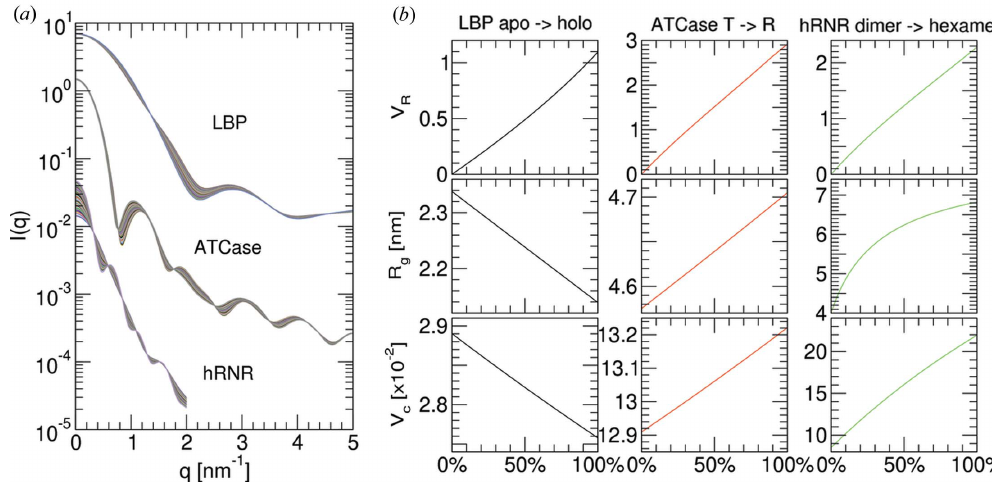
Figure 2 Theoretical modelling of the changes in structural parameters as a function of the mixtures of two conformers. ( a ) Theoretical SAXS profiles of three ligand-triggered population transitions, following open versus closed leucine-binding protein (LBP), T versus R states of aspartate carbamoyltransferase (ATCase) and dimeric versus hexameric forms of human ribonucleotide reductase (hRNR). Profiles were computed by CRYSOL based on crystal structure coordinates, see the main text for details. ( b ) Corresponding structural parameters computed from a mixture of two conformations for V R , R g and V c . V R values were calculated over 0–2 nm (cid:2) 1 for LBP and ATCase, and over 0–1 nm (cid:2) 1 for